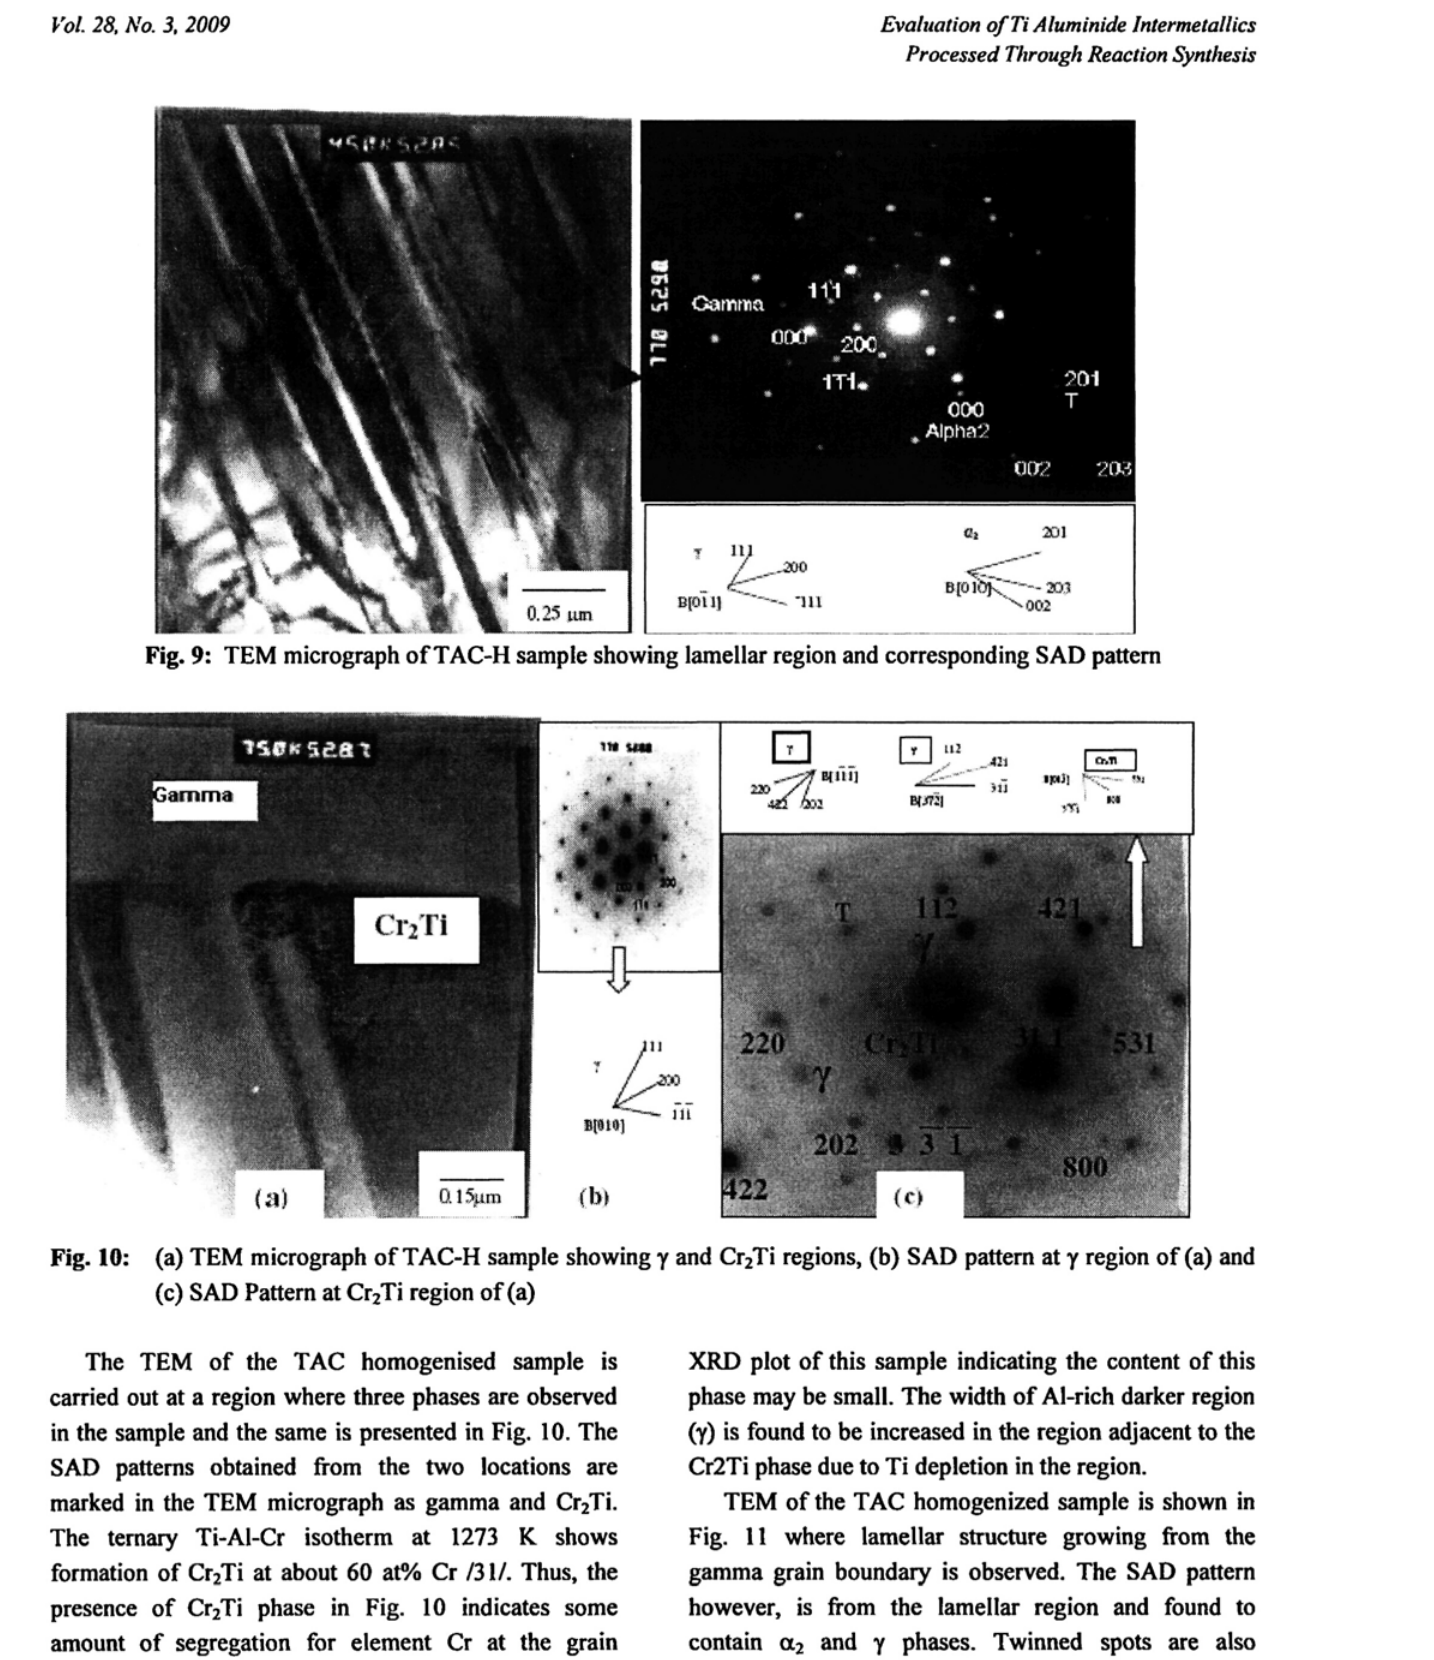
Ti regions, (b) SAD pattern at γ region of (a) and 2